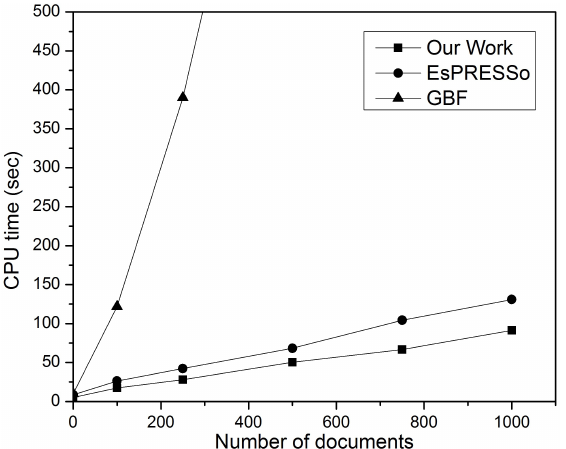
Figure 13. Performance of private and secure DSD ( m × m